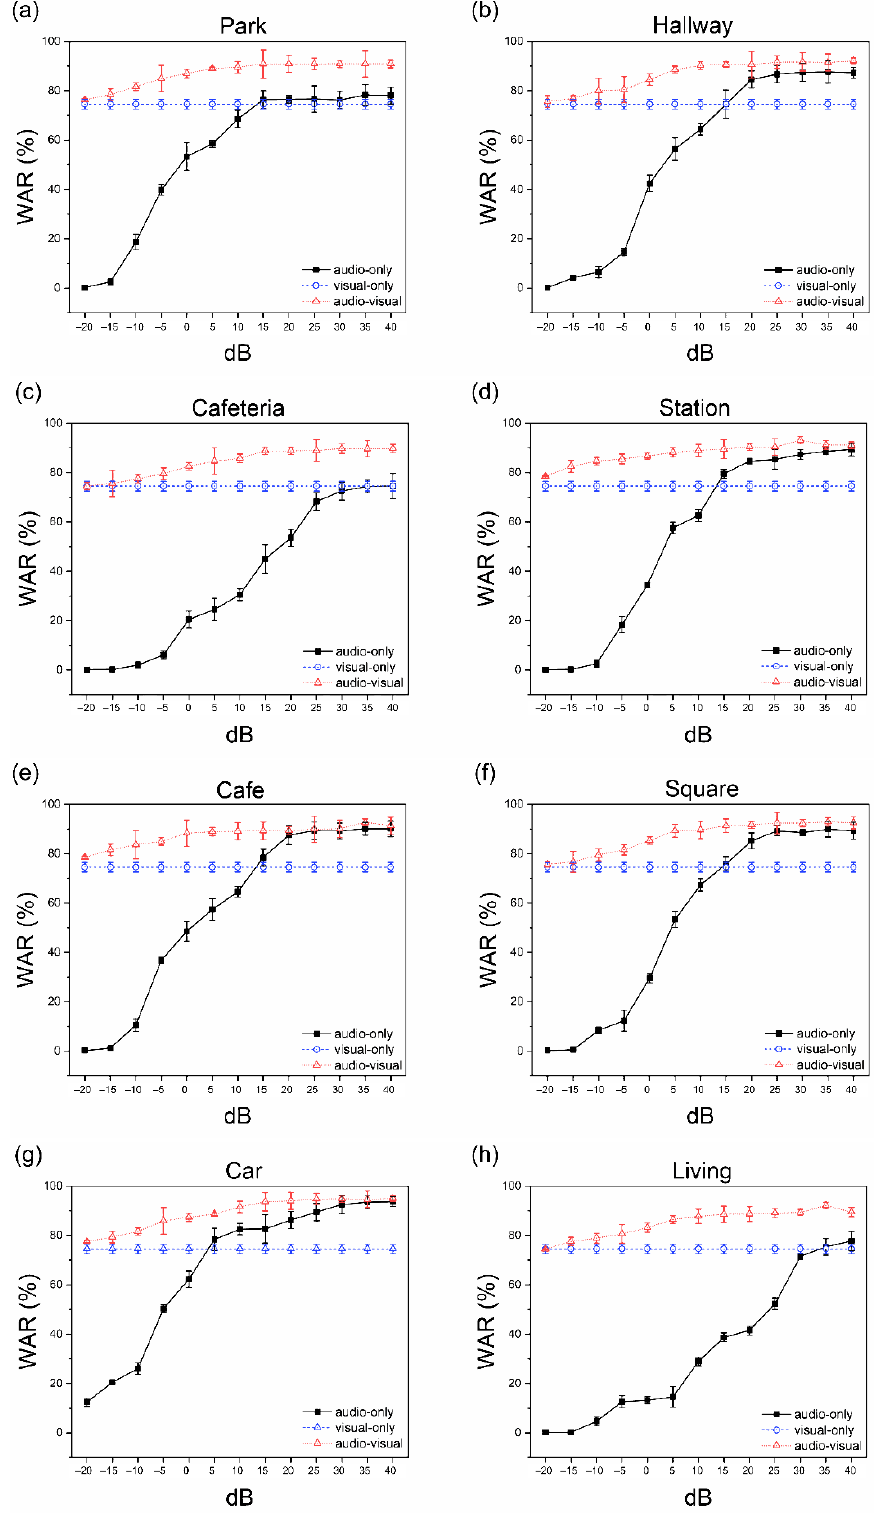
Figure 12. Average recognition accuracy rate with a standard deviation under eight noise environ- ments. Error bars represents standard deviation. The black (single-modal recognition) line represents the audio recognition result, the blue (single-modal recognition) line represents the visual recognition result, and the red (multimodal recognition) line represents the audio-visual recognition